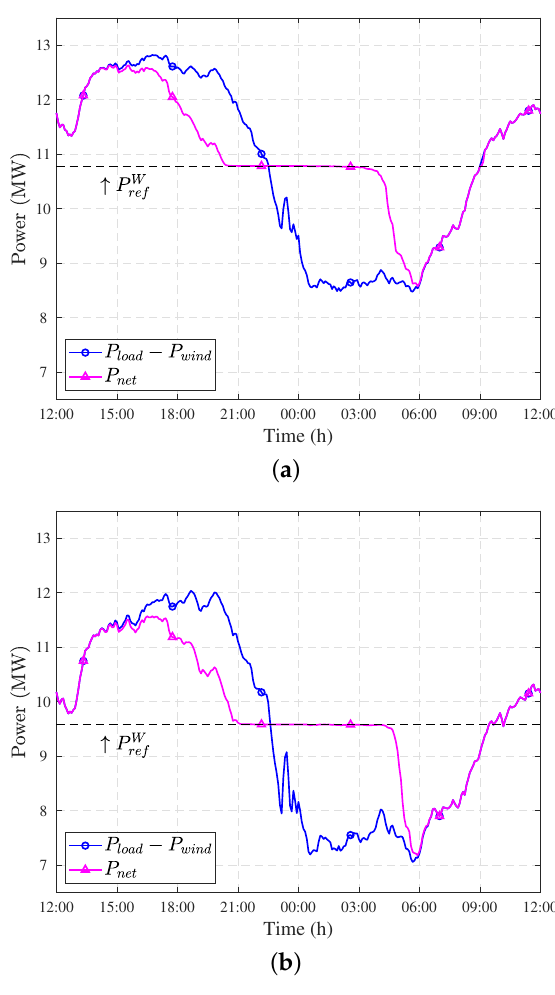
Figure 13. Net load profile of the feeder. ( a ) 10% wind power penetration; ( b ) 20% wind power